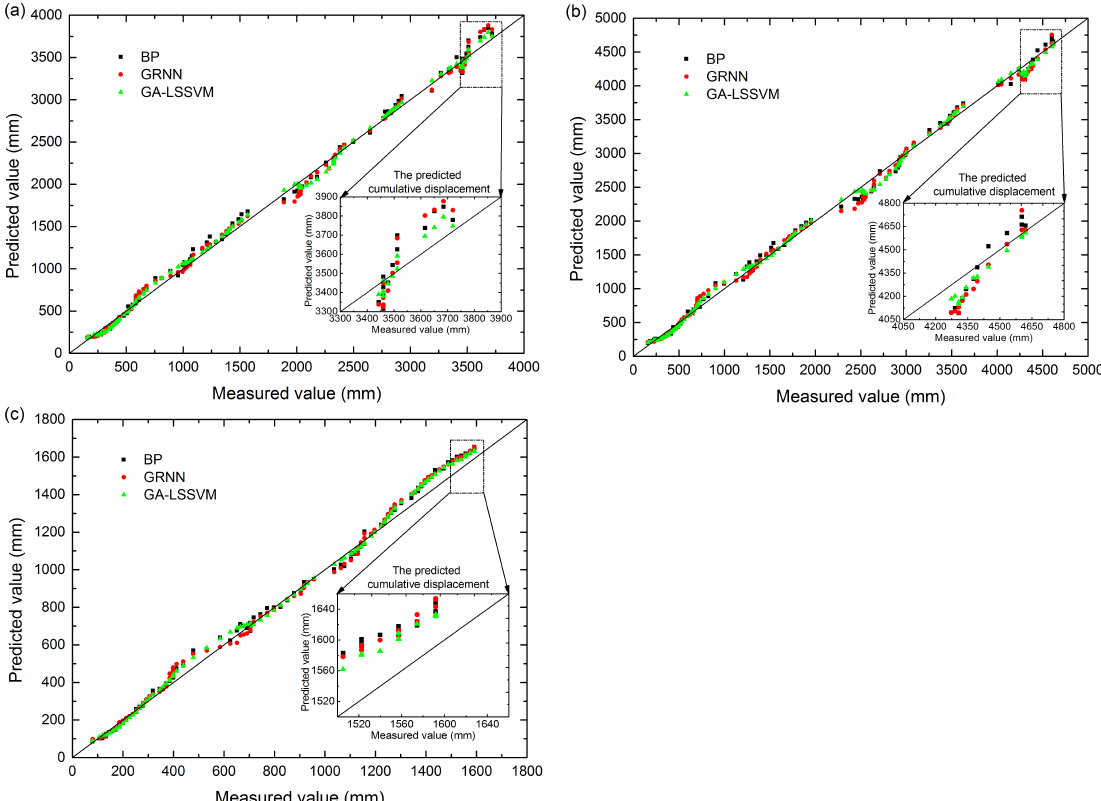
Figure 13. Measured values versus predicted values of the cumulative displacement: (a) monitoring station ZG85, (b) monitoring station ZG86 and (c) monitoring station